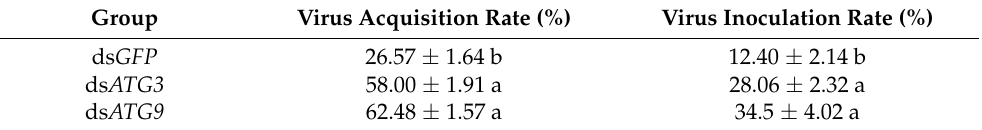
Table 3. Effects of silencing SfATG3 or SfATG9 on SRBSDV acquisition and